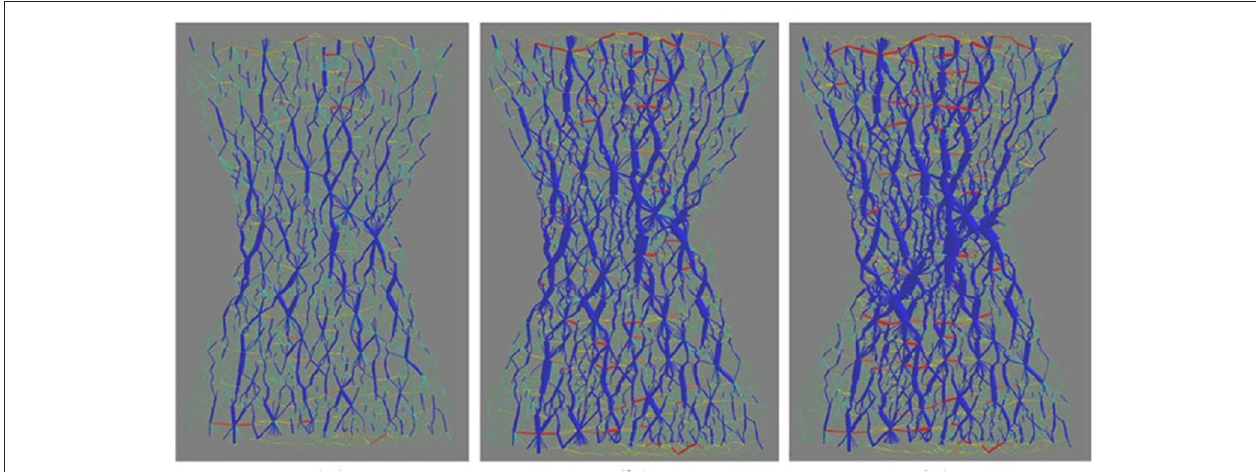
FIGURE 4 | (Color online) Alignment with applied loading of preferred paths for tensile force propagation in bonded granular materials (Nitka and Tejchman, 2015). Visualization of force transmission in DI in the pre-failure regime (peak load is to the right). Contact forces are visualized as lines joining the centers of two member particles in contact. Line thickness is proportional to the magnitude of the normal contact force. Tensile forces are shown in blue; compressive forces are in red.